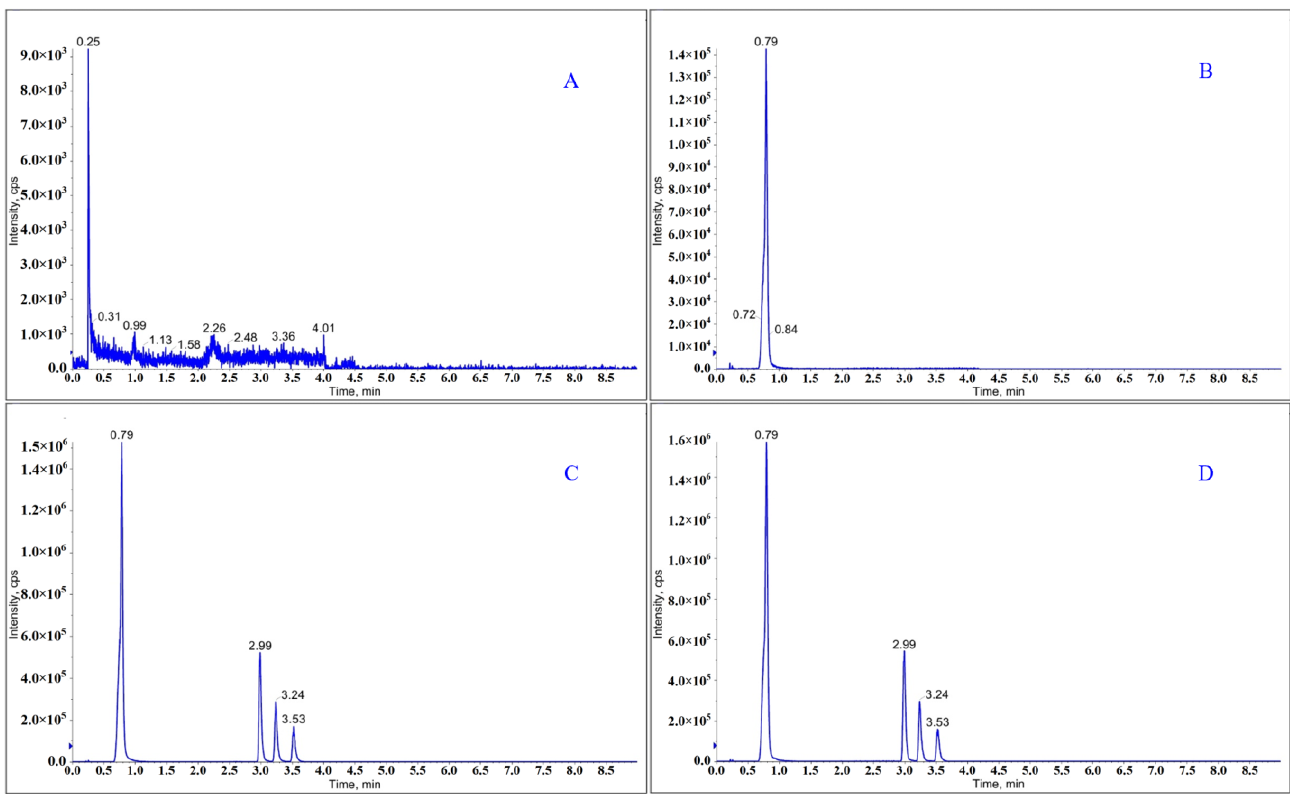
Figure 3. MRM chromatograms of ( A ) blank solutions, ( B ) TSD-1 sample solutions, ( C ) mixed standard solutions, and ( D ) sample spiked with mixed standard solutions.